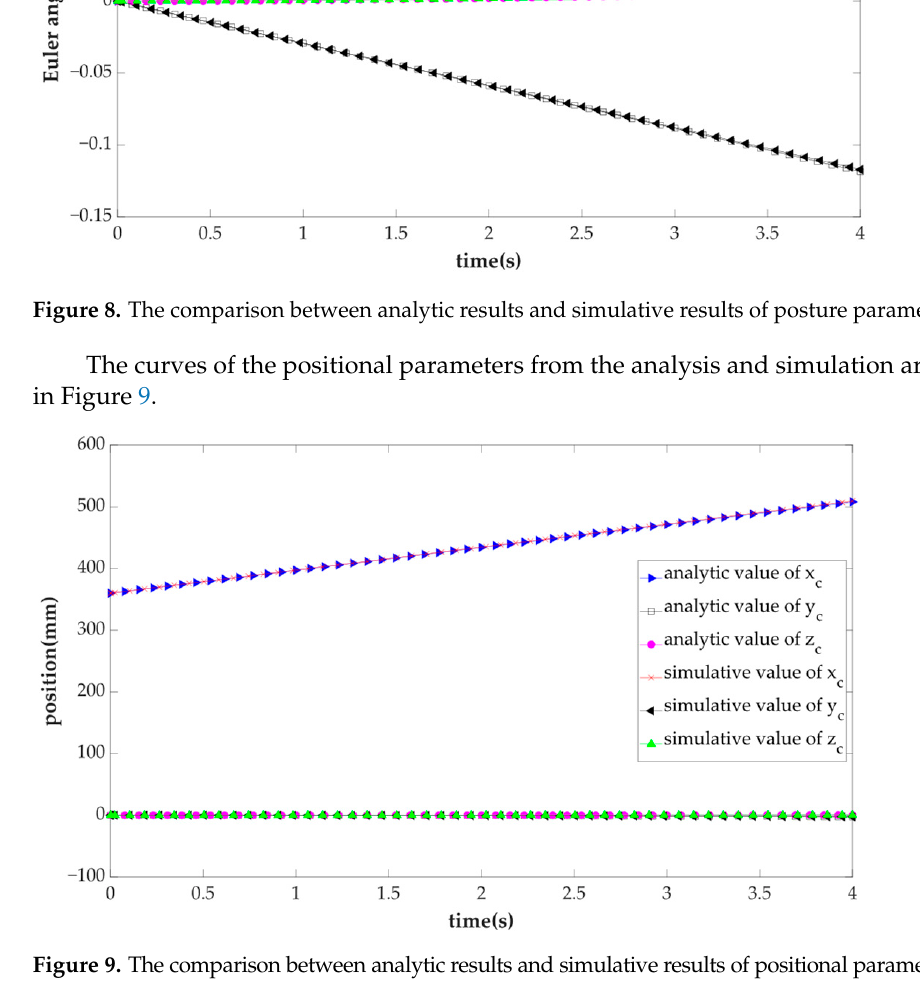
Table 2. The comparison of simulative and analytic values of positional posture parameters.